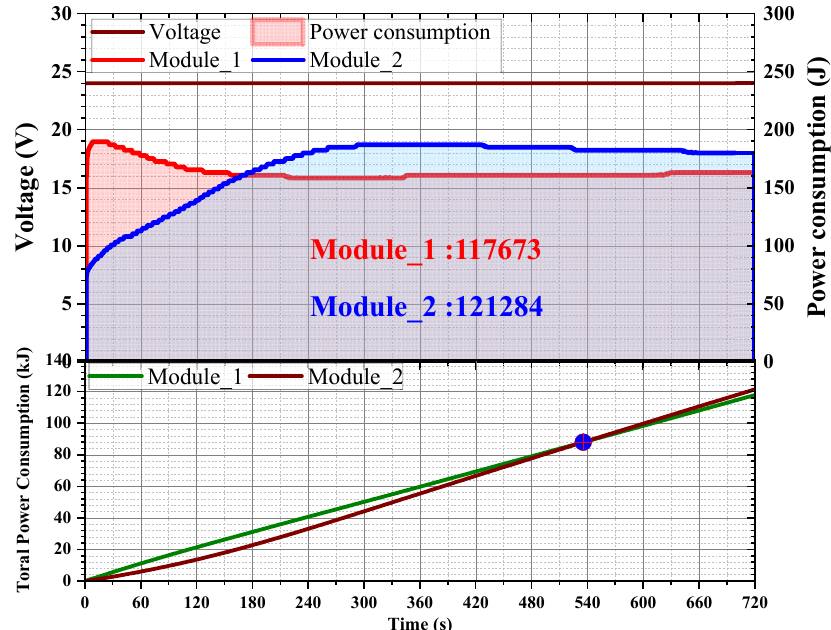
Figure 13. Power consumption with the passage of heating time. High power consumption indicated that a large amount of energy was used for melting, and power consumption and amount of melted solution exhibited similar trends. In addition, the total power consumption of Module_1 and Module_2 was the same over approximately 540 s, and the masses of melt were similar at 600 s. Table 3 lists the power consumption and the masses of melt with the passage of heating